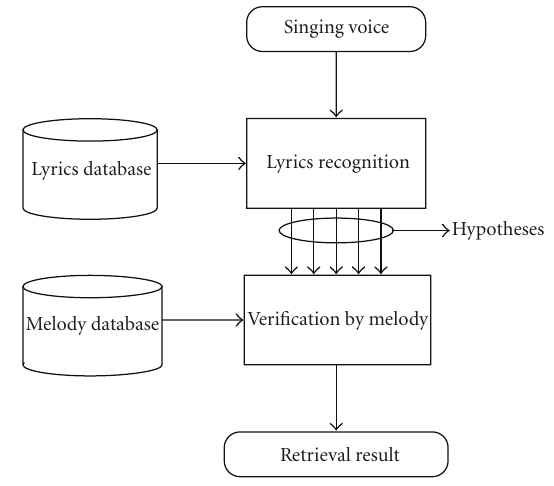
Figure 1: Outline of the MIR system using lyrics and melody.